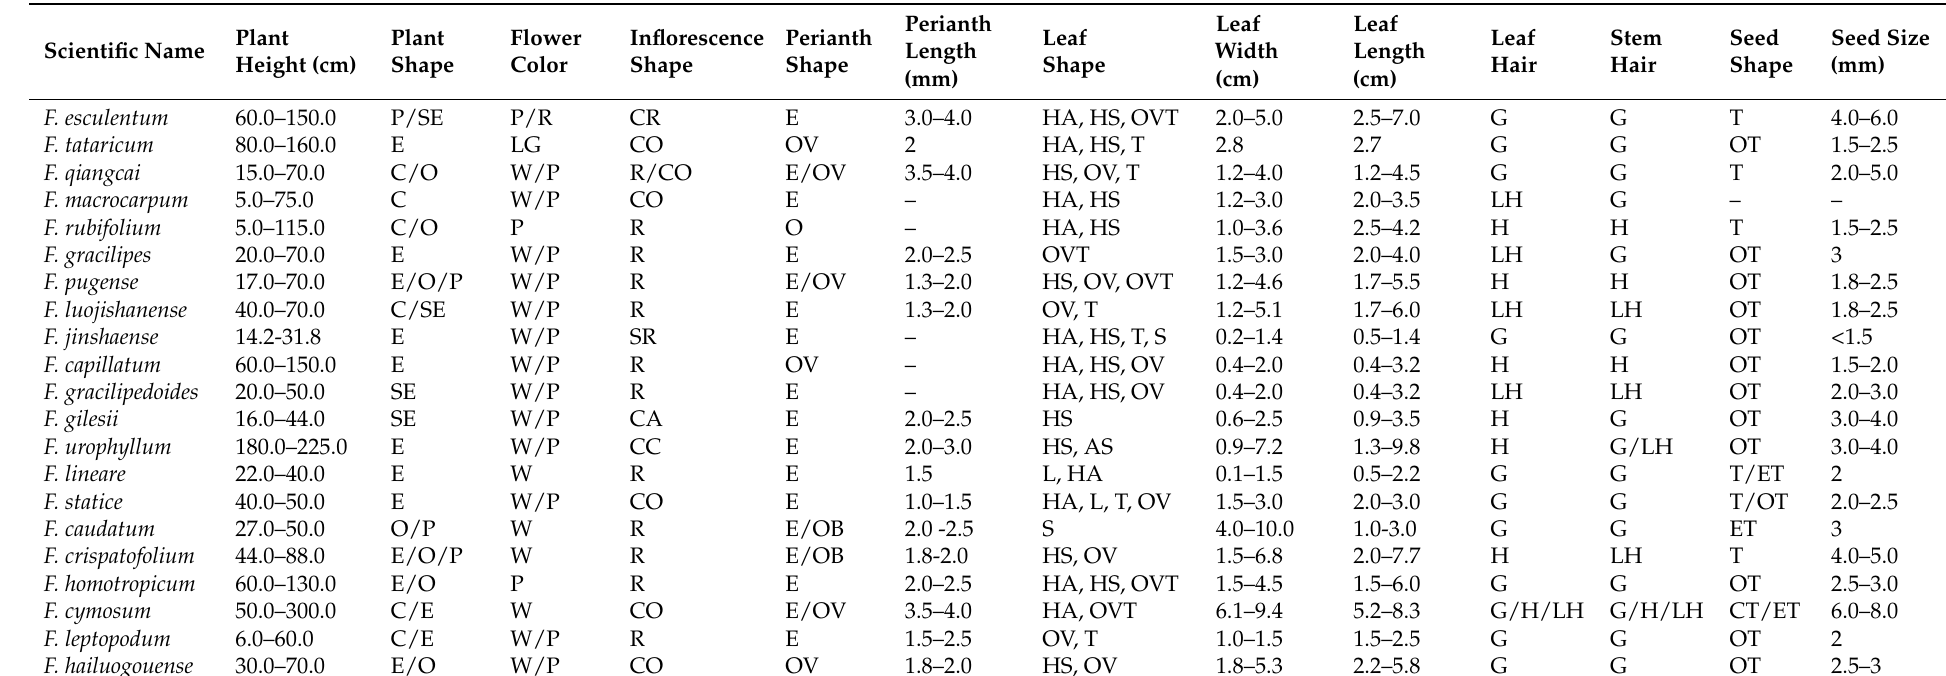
Table 3. The morphological characteristics of wild